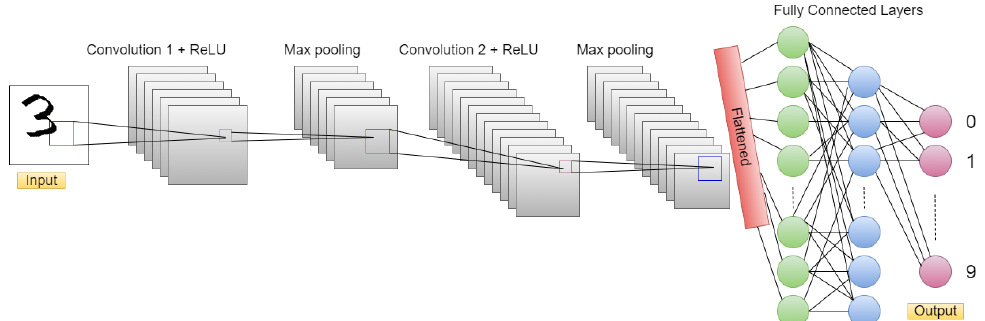
Figure 1. Illustration of CNN